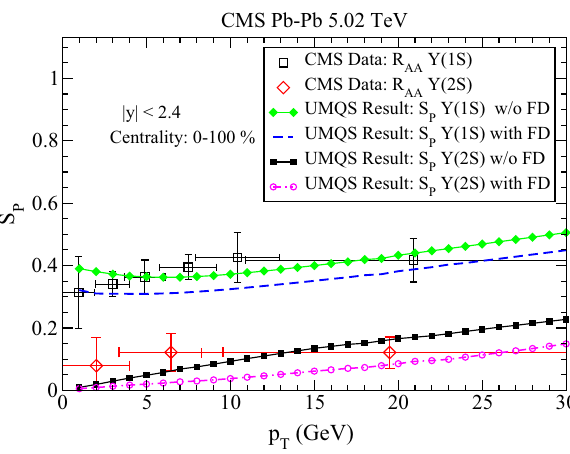
Fig. 9 Survival probability of ϒ( nS ) versus p T is compared with ϒ( nS ) nuclear modification factor R s NN = 5 . 02